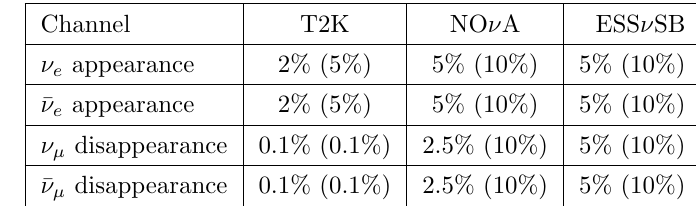
Table 2 . The signal (background) normalization errors for T2K, NO (cid:23) A and ESS (cid:23) SB . signal & background (tilt). In the \pull" method a penalty term is added in terms of the \pull" variables which is given by (cid:31) 2 errors stated above. The poissonian (cid:31) 2